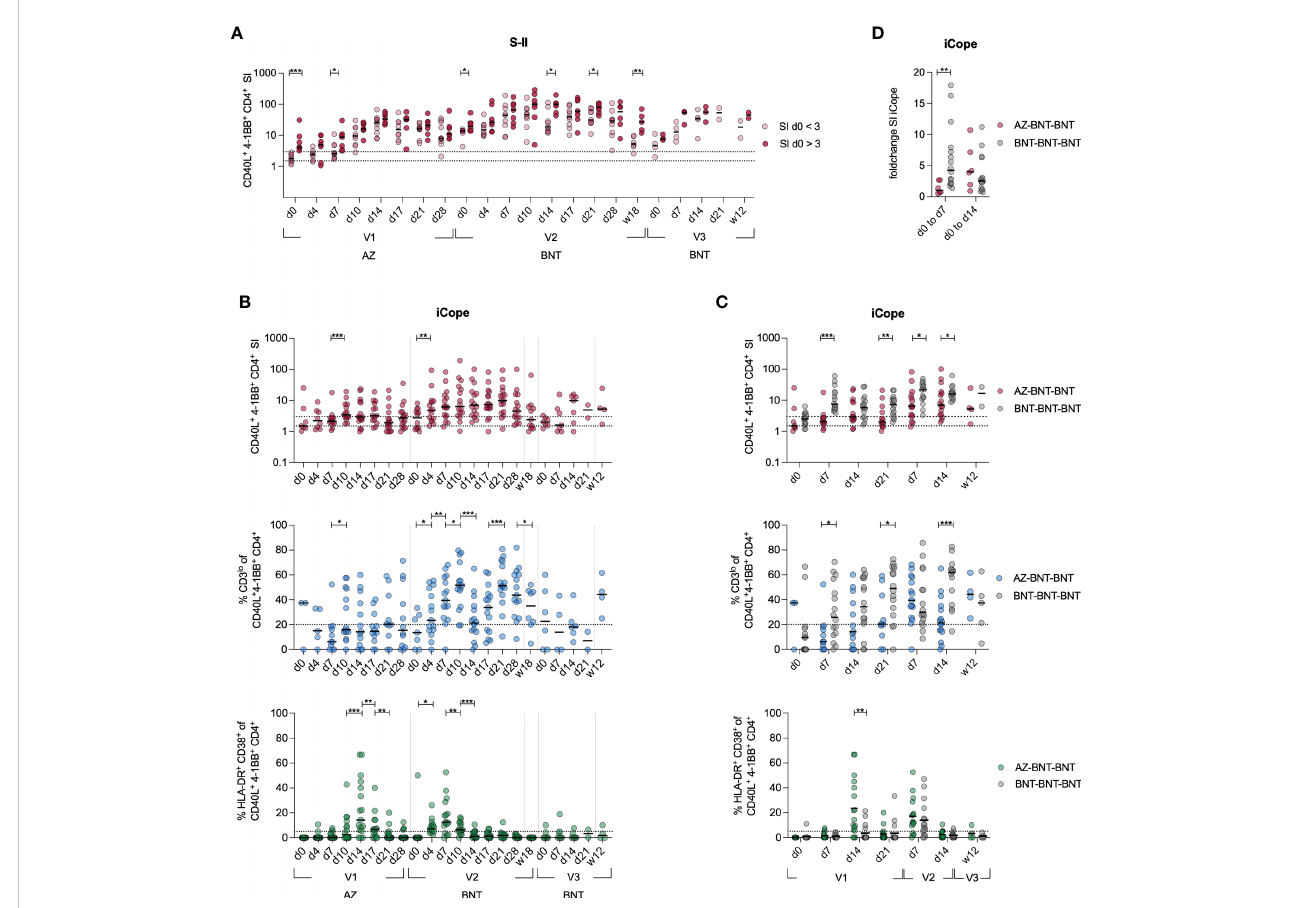
FIGURE 3 Cross-reactive cellular responses are not effectively induced by AZ primary vaccination. (A) Ex vivo stimulation of PBMCs with S-II peptide pool. Donors were separated into cross-reactive responders according to an SI of >3 at d0 and non-cross-reactive responders (baseline SI <3). (B) Stimulation index of antigen speci fi c CD40L + 4-1BB + CD4 + T cells, frequencies of CD3 lo cells among iCope-reactive CD40L + 4-1BB + CD4 + T cells of T cell responses with a SI ≥ 1.5, and HLA-DR + CD38 + among iCope-reactive CD4 + T cells are shown. (C) Comparison of SI, CD3 lo and HLA-DR + CD38 + between heterologous (AZ- BNT-BNT) and homologous (BNT-BNT-BNT) vaccinated donors. (D) Foldchange of the SI of iCope-speci fi c T cells from d0 to d7 and d0 to d14. Only signi fi cant differences are shown with * P < 0.05, ** P < 0.01, *** P < 0.001. A, C-D: Mann-Whitney test B: Wilcoxon matched-pairs signed-rank test. SI below 1 were excluded from further analysis, as they are below the lower limit of detection. Black line indicates the